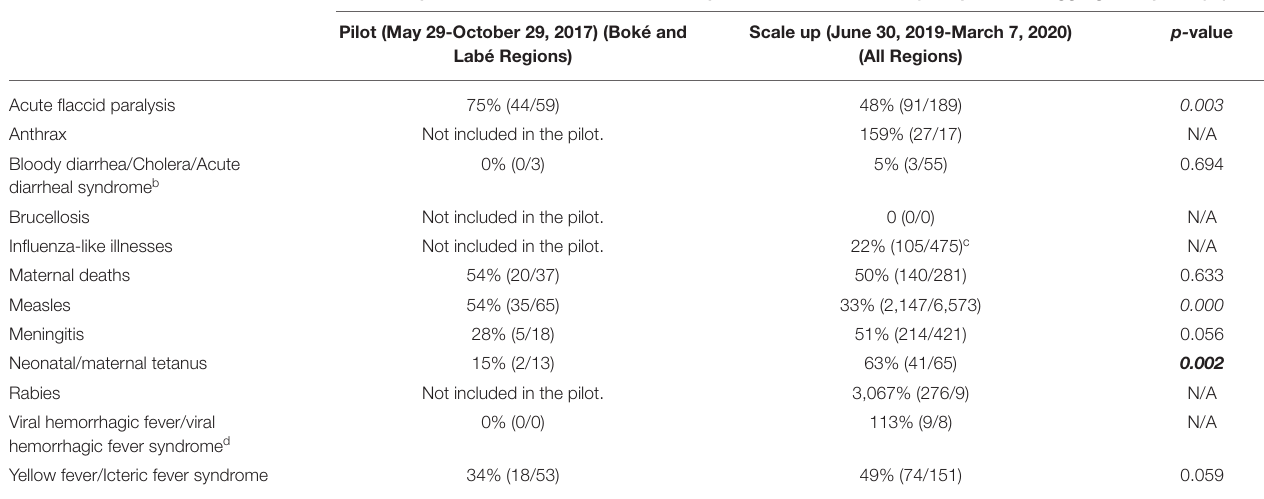
TABLE 3 | Comparison of individual case reports as a percentage of weekly aggregate reports across pilot and scale-up periods. Difference in proportions between the pilot and scale up were calculated using Chi-squared tests. Disease/event a Comparison between individual case reports in DHIS2 and weekly suspect case aggregate reports